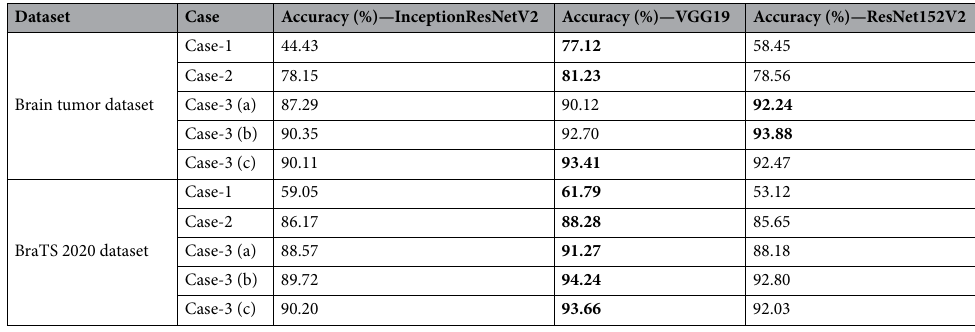
Table 5. Classification performance of generated images in brain tumor dataset and BraTS 2020 dataset, where Case-1: considering the complete original images and the generated images as training and testing data respectively, Case-2: considering 80% of the mixture of original and generated images as training data and the remaining as testing data and Case-3: considering 20% of the original images as testing data and choosing the training data by three different ways: (a) remaining 80% only, (b) remaining 80% along with all generated images and (c) remaining 80% along with augmented images created by- shift, flip and